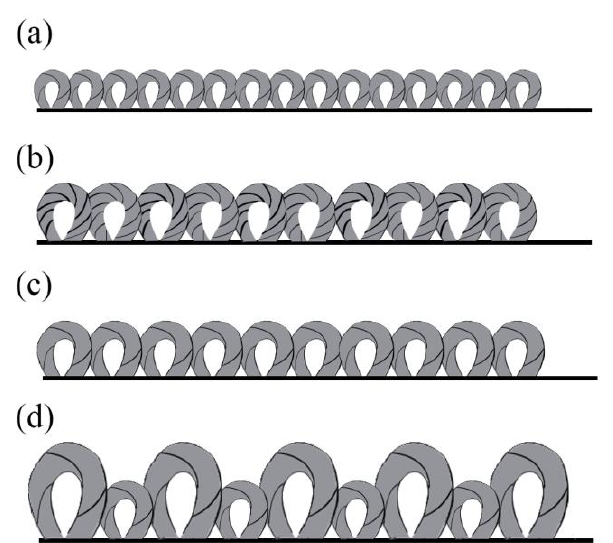
Figure 4. sketches of carpet loop structure ( a ) carpet 1, ( b ) carpet 2, ( c ) carpet 3, and ( d ) carpet 4. For addressing the chroma and hue of the dyed carpet in terms of CIE a and CIE b scales, similar decreasing trends as L* values were observed from light to darker shades (Figure 3c–f). For the red and green-colored carpets, reflected light mainly contains red and green associated wavelengths (620–780 nm) in the visible wavelength region. As previously discussed, a higher concentration of colorant molecules will result in more absorption of incident light for a certain wavelength. Hence, from light to dark shades, more absorption of corresponding red and green wavelengths occurred, which resulted in less reflection of the red and green light spectra along with other color wavelengths, which reduces the chroma values of a* and b*.